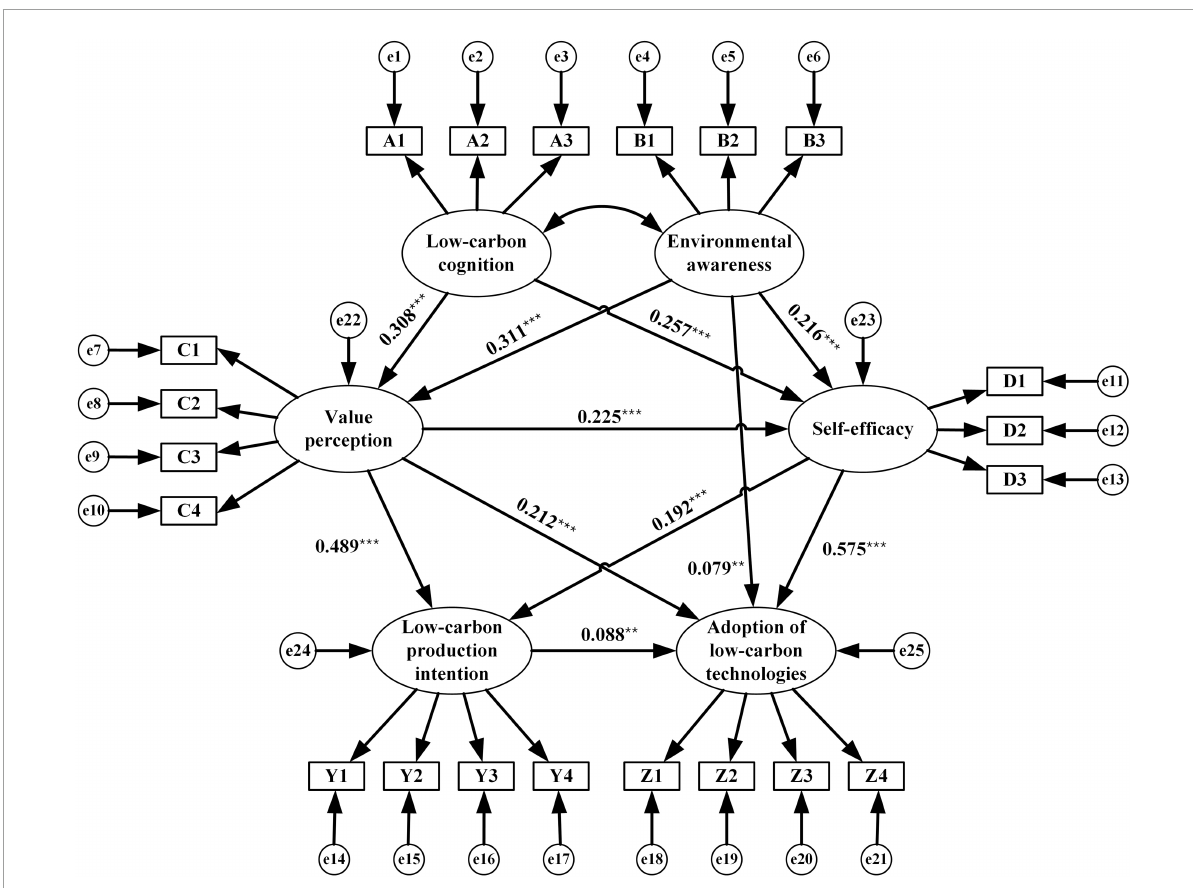
FIGURE3 Path model and standardized factor loadings. ** and *** represent significant at 5% and 1%,